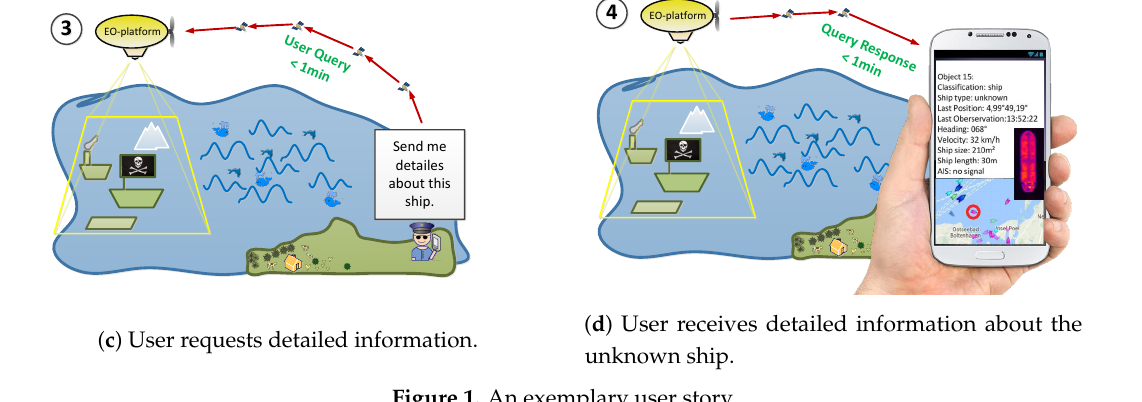
Figure 1. An exemplary user